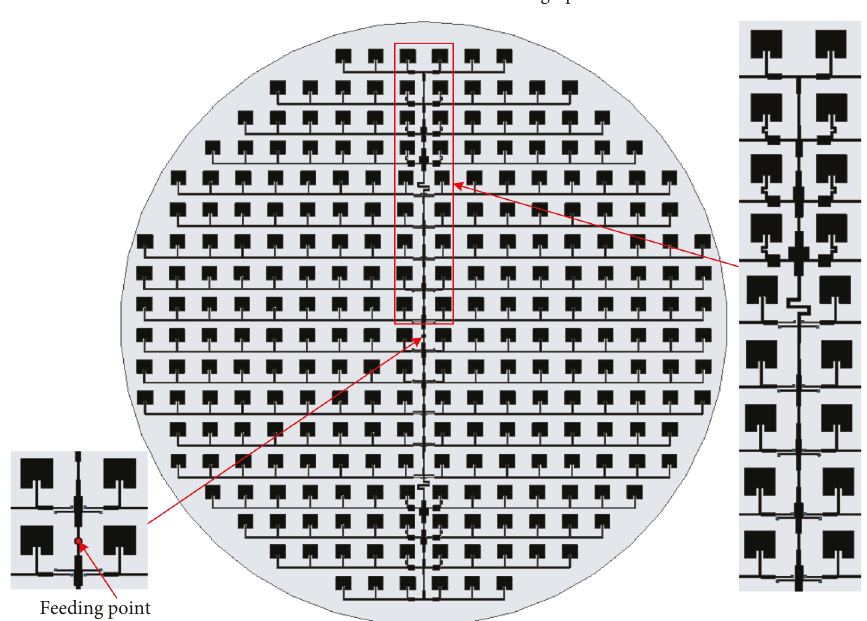
Figure 1: Configuration of the proposed antenna array.